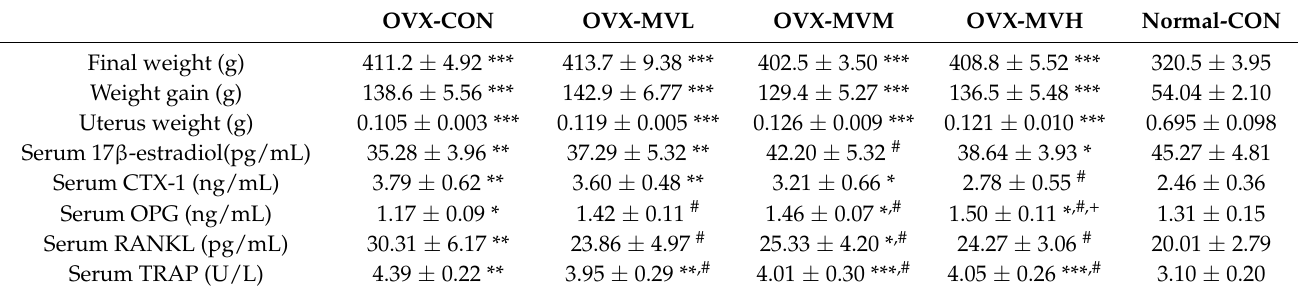
Table 2. Body weight and bone metabolism.